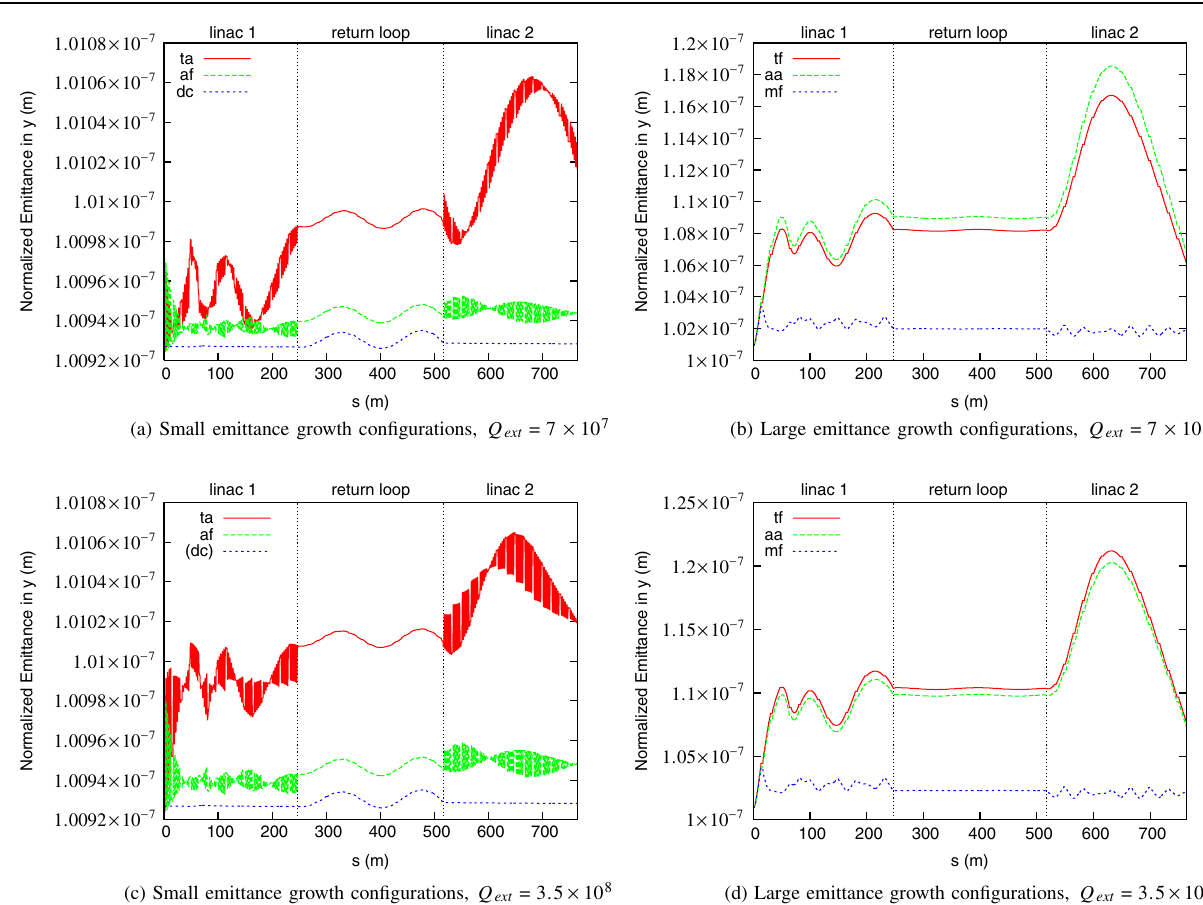
FIG. 3. (Color) Normalized emittance in the y